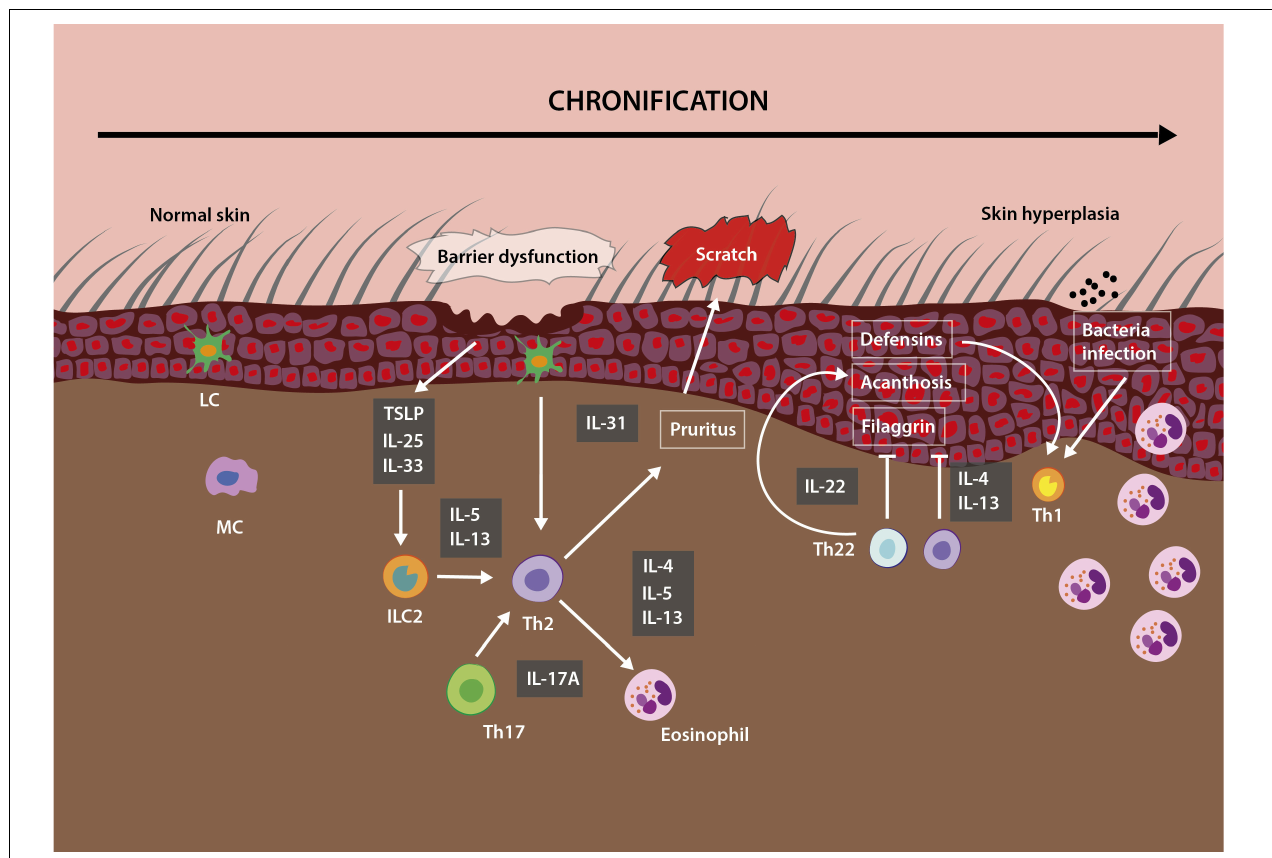
FIGURE 2 | Immune responses involved in chronification of lesions in AD. Scratching resulting from pruritus (the main symptom of AD), makes keratinocytes react by releasing cytokines important for inflammation, including TSLP (thymic stromal lymphopoetin), IL-33, and IL-25. IL-33 activates innate lymphoid cells 2 (ILC2) and Th2 lymphocytes. The release of IL-31 stimulates even more the pruritus. In response to IL-22, keratinocytes proliferate, resulting in diffuse epidermal hyperplasia. Eosinophils accumulate in chronic atopic skin. MC: mast cells; LC: Langerhans cells; ILC2: Innate lymphoid cell